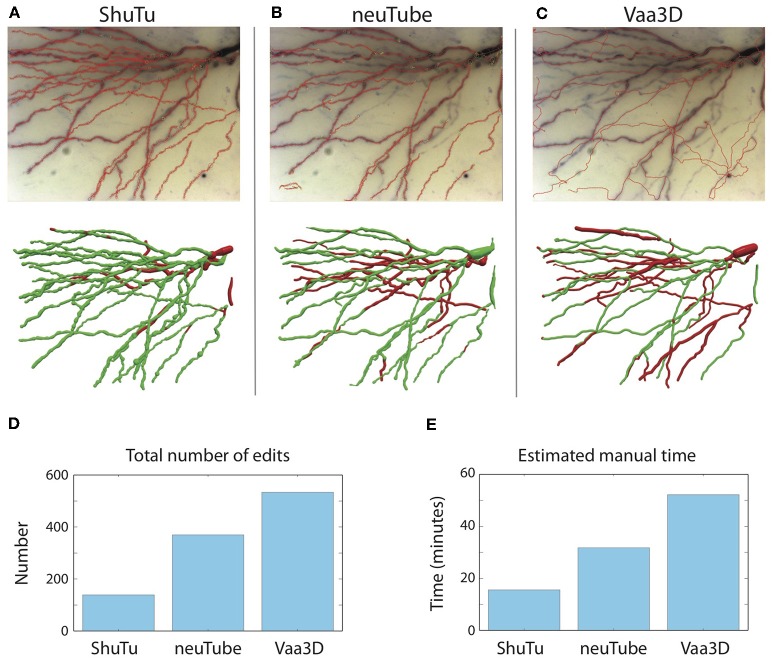
Comparisons of automated reconstructions from ShuTu, neuTube, and Vaa3D. (A) Automated reconstruction generated by ShuTu on one image tile (red circles) overlaid on the 2D minimum-intensity projection of the tile (top). The tile covers part of the basal dendrites of the neuron shown in Figure 1. The SWC structure after manual editing (below). Green indicates the SWC points automatically generated; red indicates those added during the editing. (B) Automated reconstruction generated by neuTube. (C) Automated reconstruction generated by Vaa3D. (D) Comparison of the NEO (number of editing operations) for the three methods. (E) Comparison of the estimated manual editing time for the three methods.